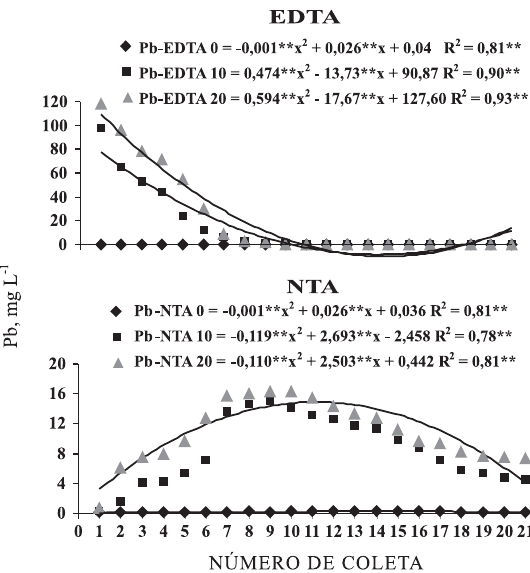
Figura 3. Concentração de Pb em função do número de coletas, após aplicação das doses (0, 10 e 20 mmol kg -1 ) dos quelantes EDTA e